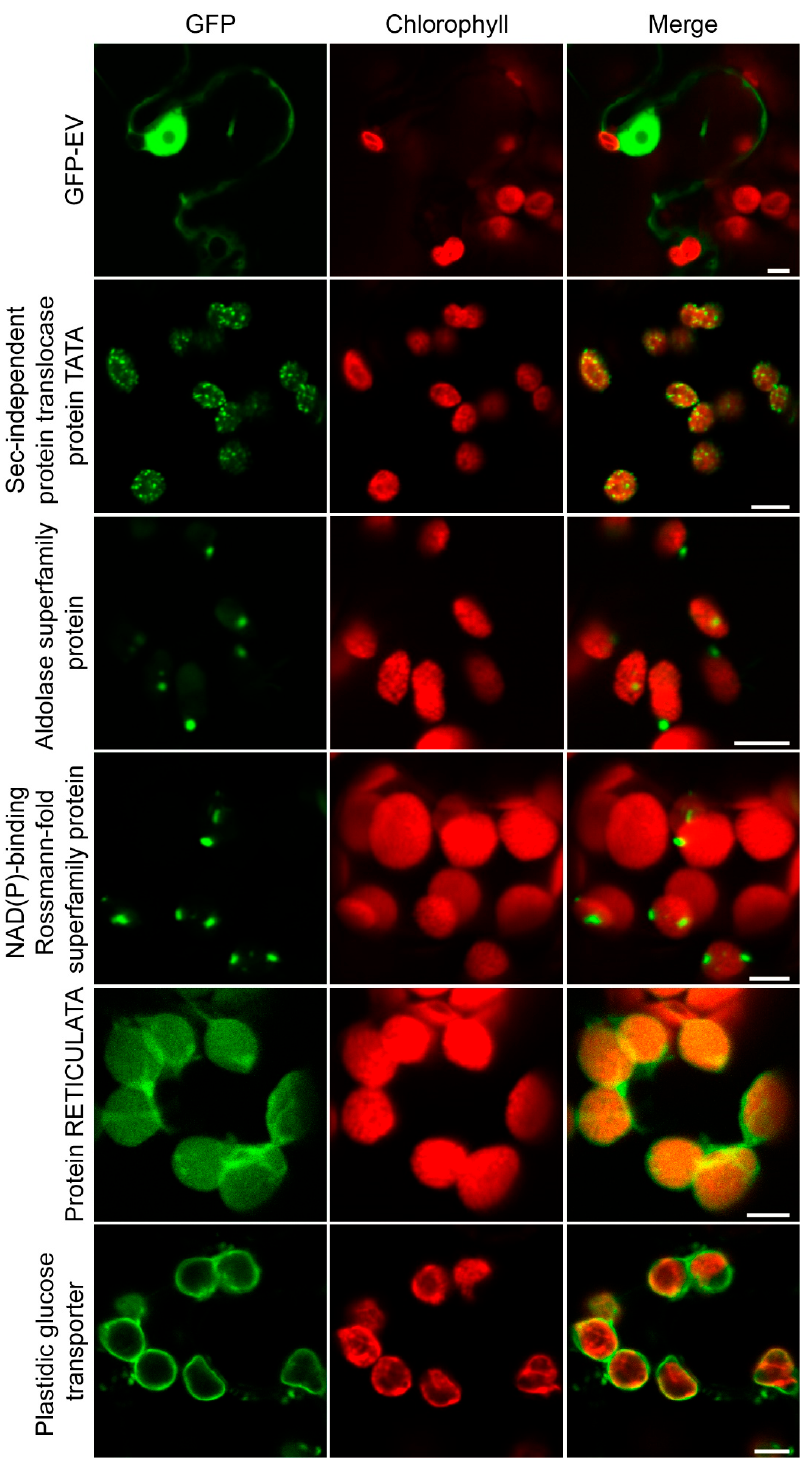
Figure 4. Subcellular localization analysis of representative identified proteins. The GFP alone and the GFP fusion constructs (genes-eGFP) were transiently expressed in N. benthamiana leaves via agroinfiltration. The images of epidermal cells were taken at 60 hpi by CLSM (TCS SP8 DLS, Leica, Wetzlar, Germany). 01G036490.1, Sec-independent protein translocase protein TATA; 05G004320.1, Aldolase superfamily protein; 06G027060.1, NAD(P)-binding Rossmann-fold superfamily protein; 09G001570.1, Protein RETICULATA; 02G026040.1, plastidic glucose transporter (pGlcT). Bars, 10 µ